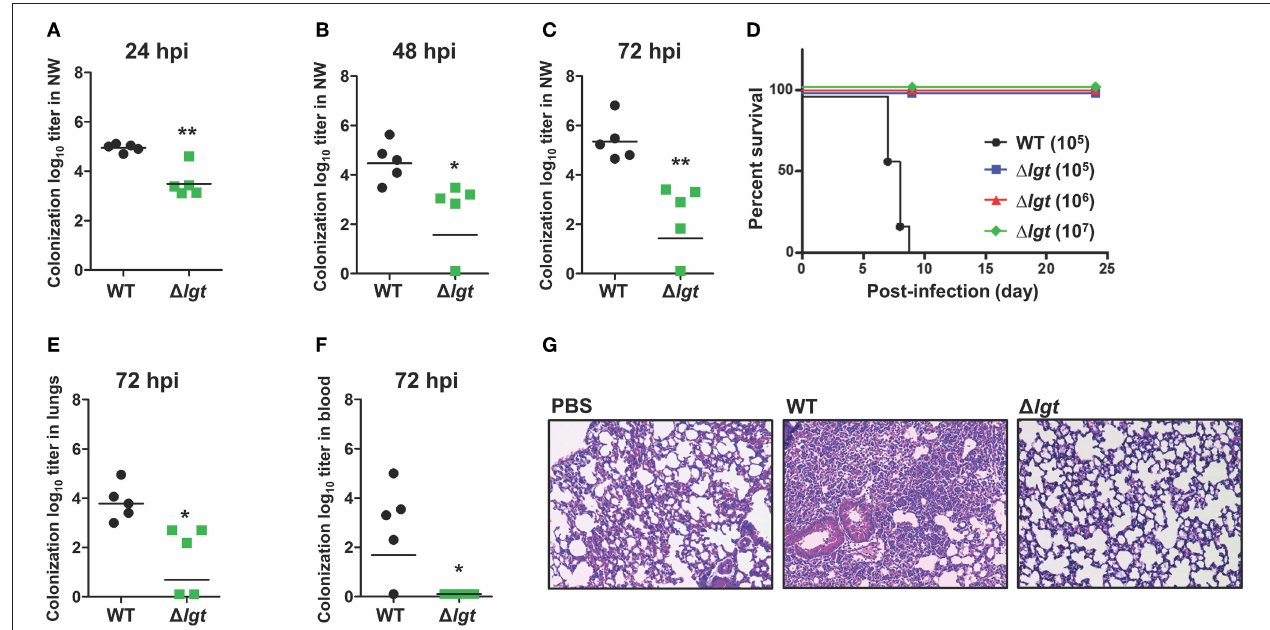
FIGURE 2 | Durable Colonization of TIGR4 1 lgt in the Nasopharynx. (A–C) Pneumococcal colonization of the nasopharynx in mice ( n = 5 per group) inoculated intranasally (i.n.) with either wild-type (WT) or 1 lgt TIGR4 (10 7 CFU) at 24h (A) , 48h (B) , and 72h (C) after inoculation. (D) Survival of mice ( n = 10 per group) inoculated i.n. with either WT (10 5 CFU) or 1 lgt TIGR4 (10 5 , 10 6 , or 10 7 CFU). (E,F) Pneumococcal numbers in serially diluted lung tissue homogenates (E) and blood (F) from mice ( n = 5 per group) inoculated i.n. with either WT or 1 lgt TIGR4 (10 7 CFU) at 3 days after infection. (G) Hematoxylin & eosin (H&E) staining of lungs from mice inoculated with WT or 1 lgt TIGR4 (10 7 CFU). * P < 0.05 and ** P < 0.01 compared with the WT-infected mouse